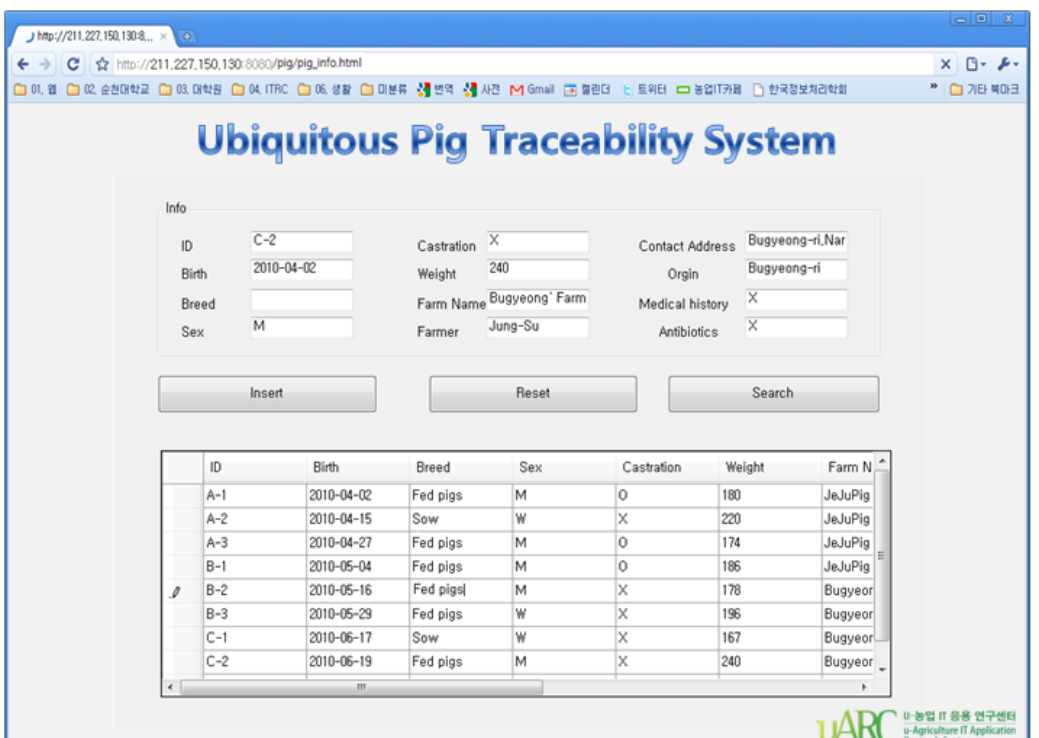
Figure 16. Ubiquitous Pig Traceability System